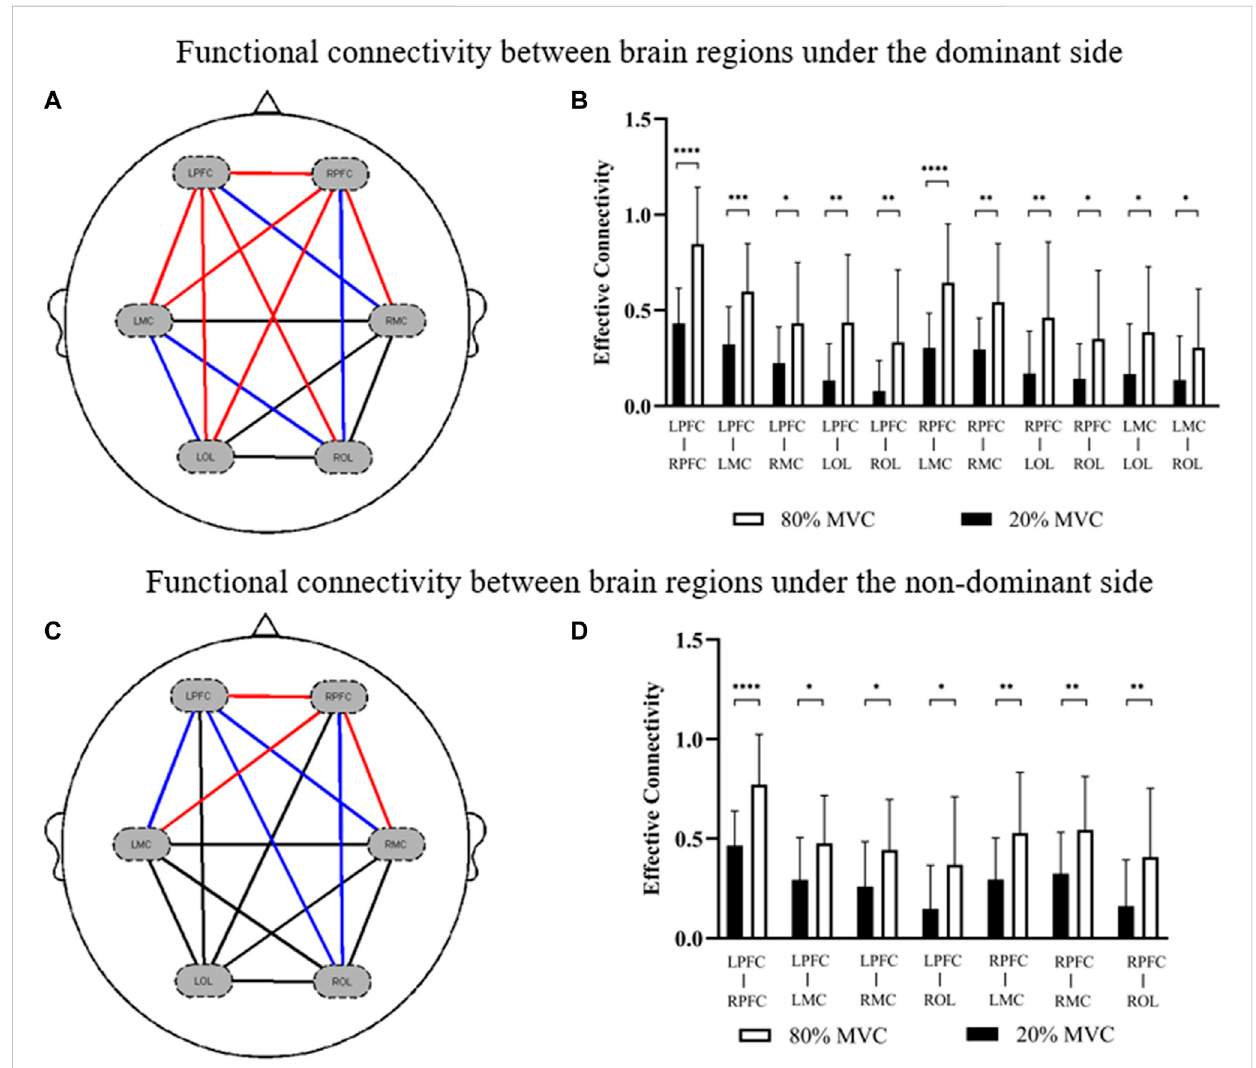
FIGURE 3 Theresults ofsigni fi cantdifferencesinfunctionalconnections between brainregionsindifferentconditions. (A,B) The changeisrepresentedbythe functionalconnectivity ofthe80%MVCrelativetothe20%MVCunderthedominantside. (C,D) Thechangeisrepresentedbythefunctionalconnectivity of the 80% MVC relative to the 20% MVC under the non-dominant side. The red line ( p < 0.01) and blue line (0.01 < p < 0.05) indicate signi fi cant increase